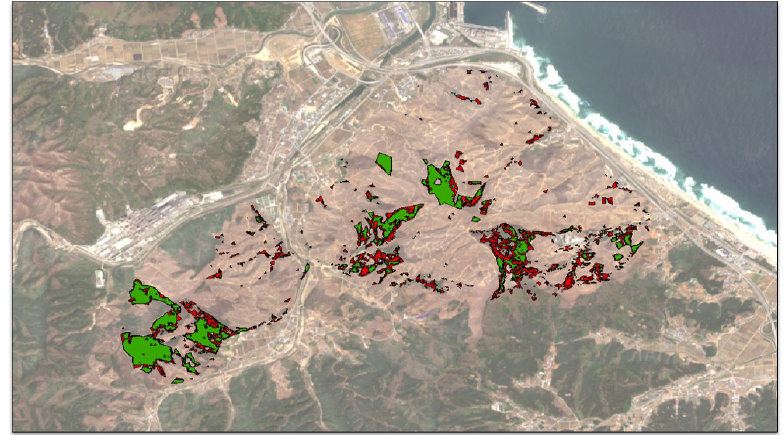
Figure 10. Comparison of the proposed method and NDVI with NBR: green indicates the extracted areas of the proposed method and red indicates the extracted areas of difference normalized burn ratio (dNBR) with NDVI.